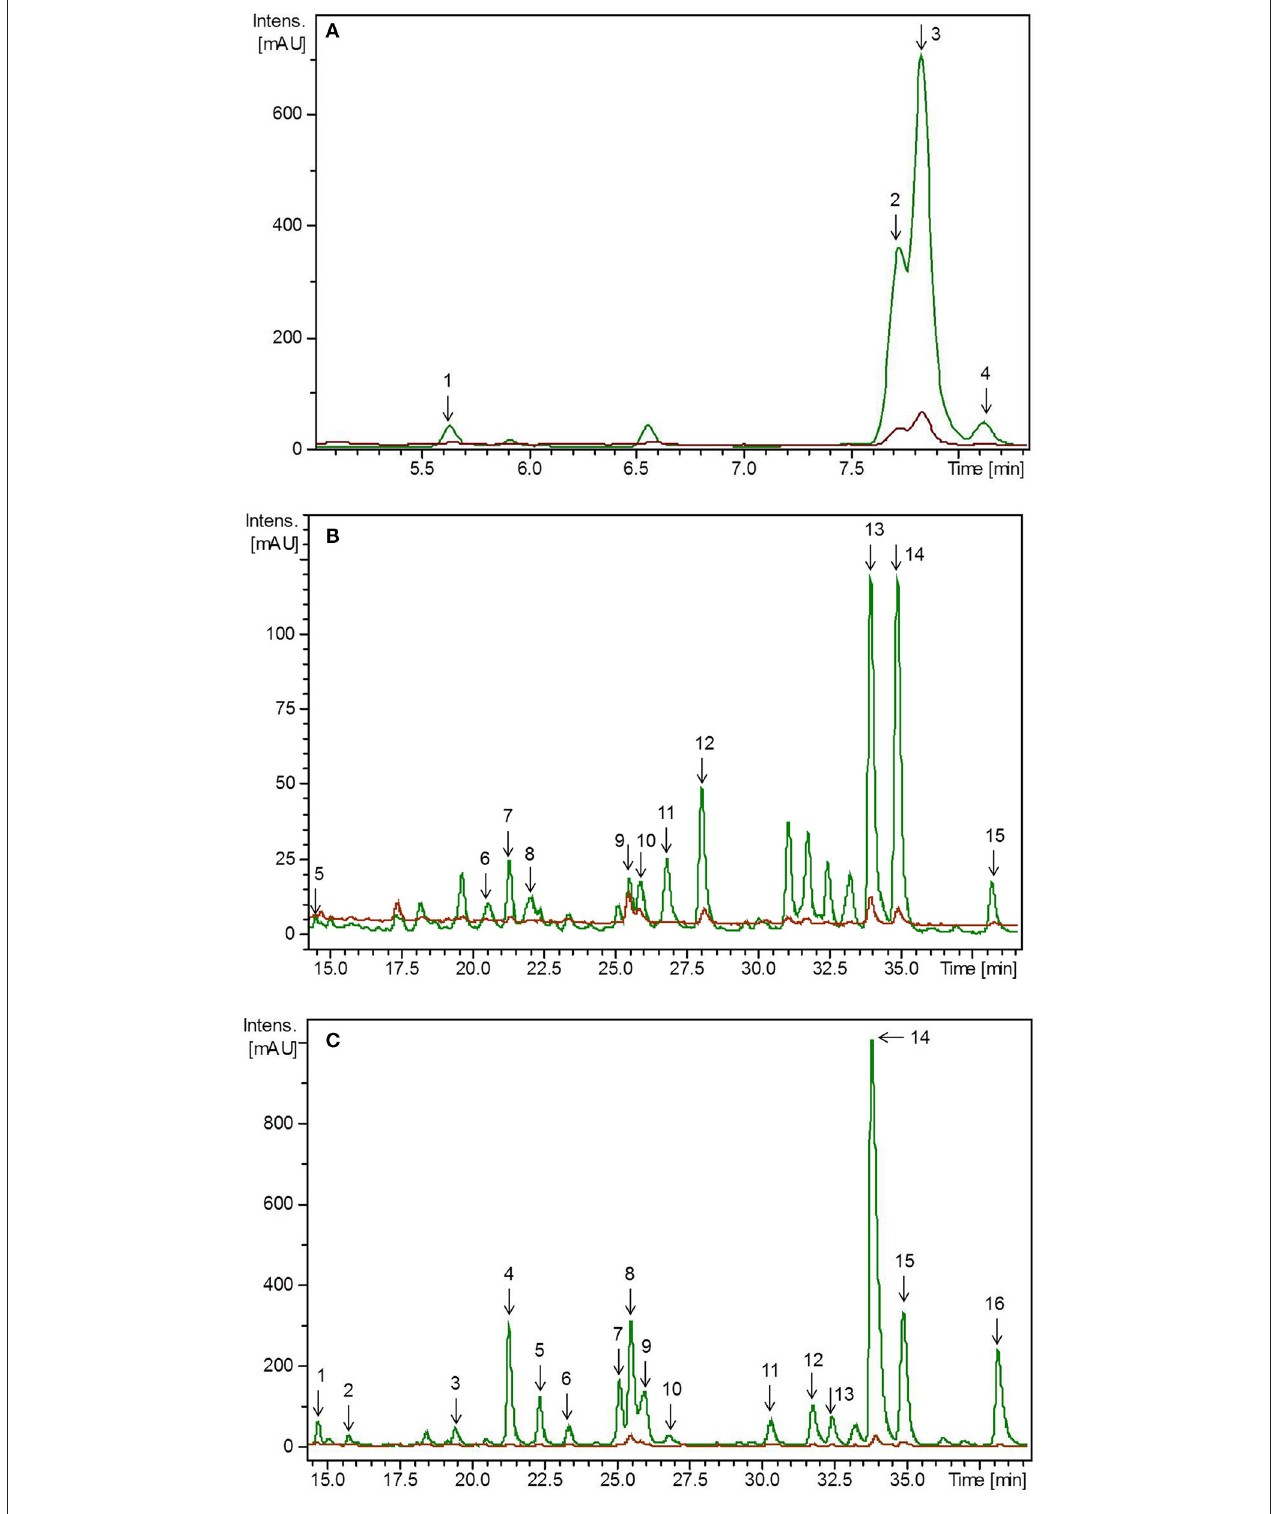
FIGURE 3 | HPLC-chromatogram of flavonoid glycosides in (A) lupin microgreens (green) vs. lupin microgreen bread (brown) in the time range 4–8min, (B) lupin microgreens (green) vs. lupin microgreen bread (brown) in the time range 15–40min and (C) lupin leaves (green) vs. lupin leaf bread (brown). Intensity in mAU, extract at 330nm. The bread contains 10.7% plant material, hence a dilution factor of 10.7% has to be taken into account. (A) Compounds are numbered in chronological